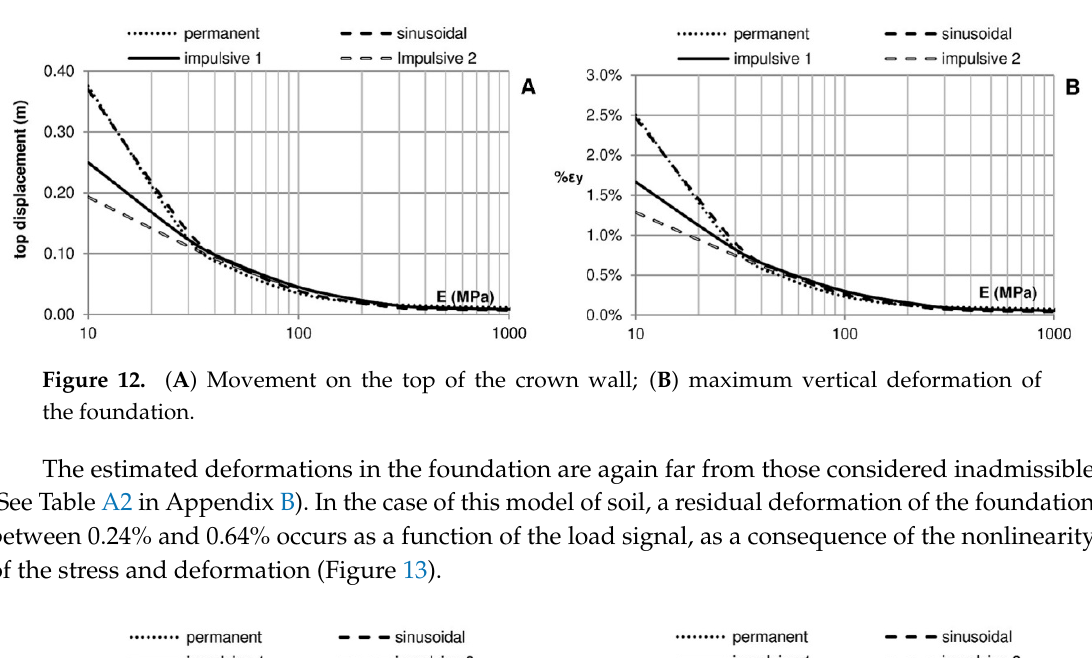
Figure 13. ( A ) Residual movement on the top of the crown wall; ( B ) residual vertical deformation.